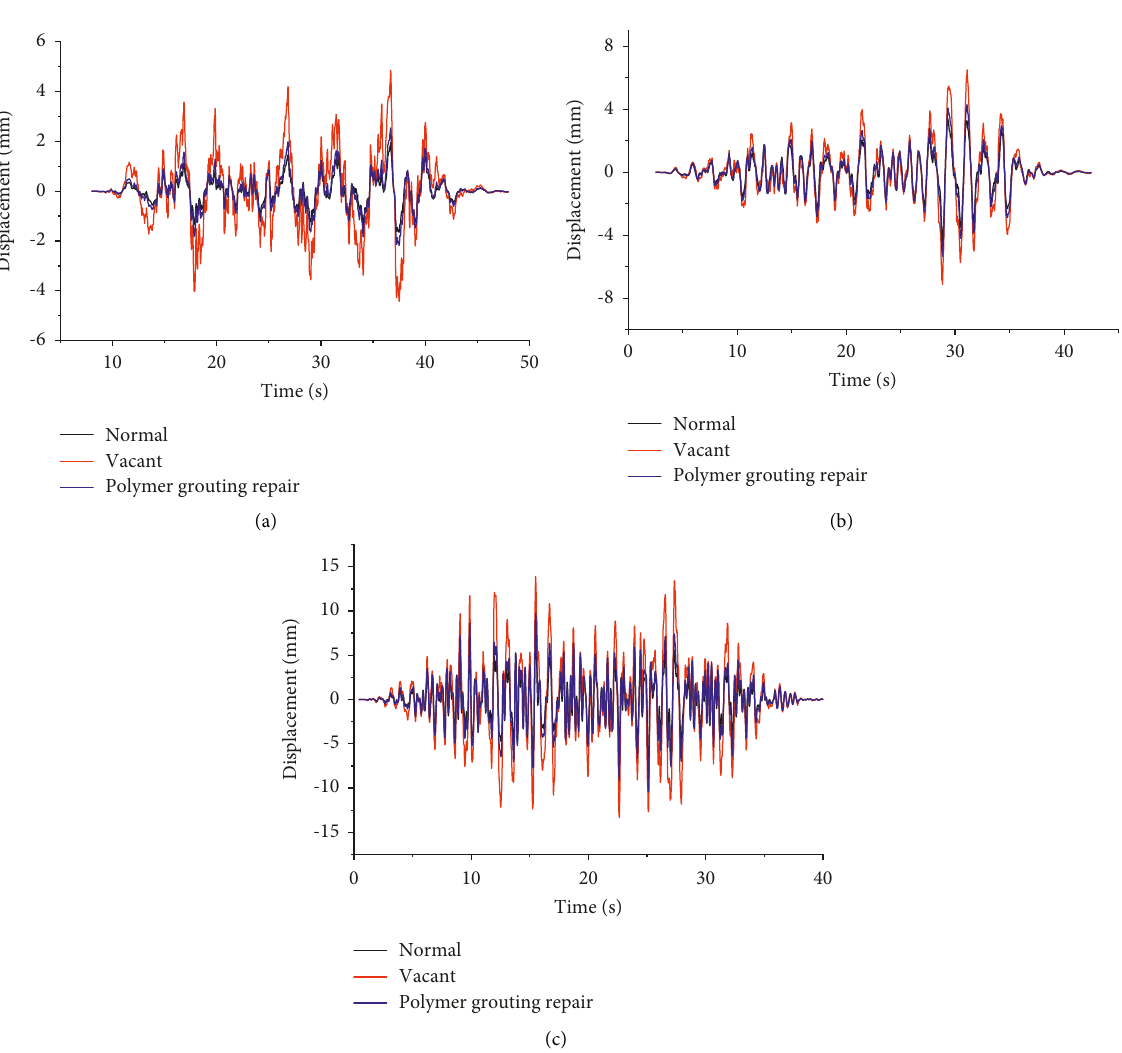
Figure 8: Longitudinal vibration displacement time curve of the pipe under normal, vacant, and polymer grouting repair. (a) At 800 m, wave speed v � 100m/s. (b) At 500m, wave speed v � 200m/s. (c) At 200 m, wave speed v �